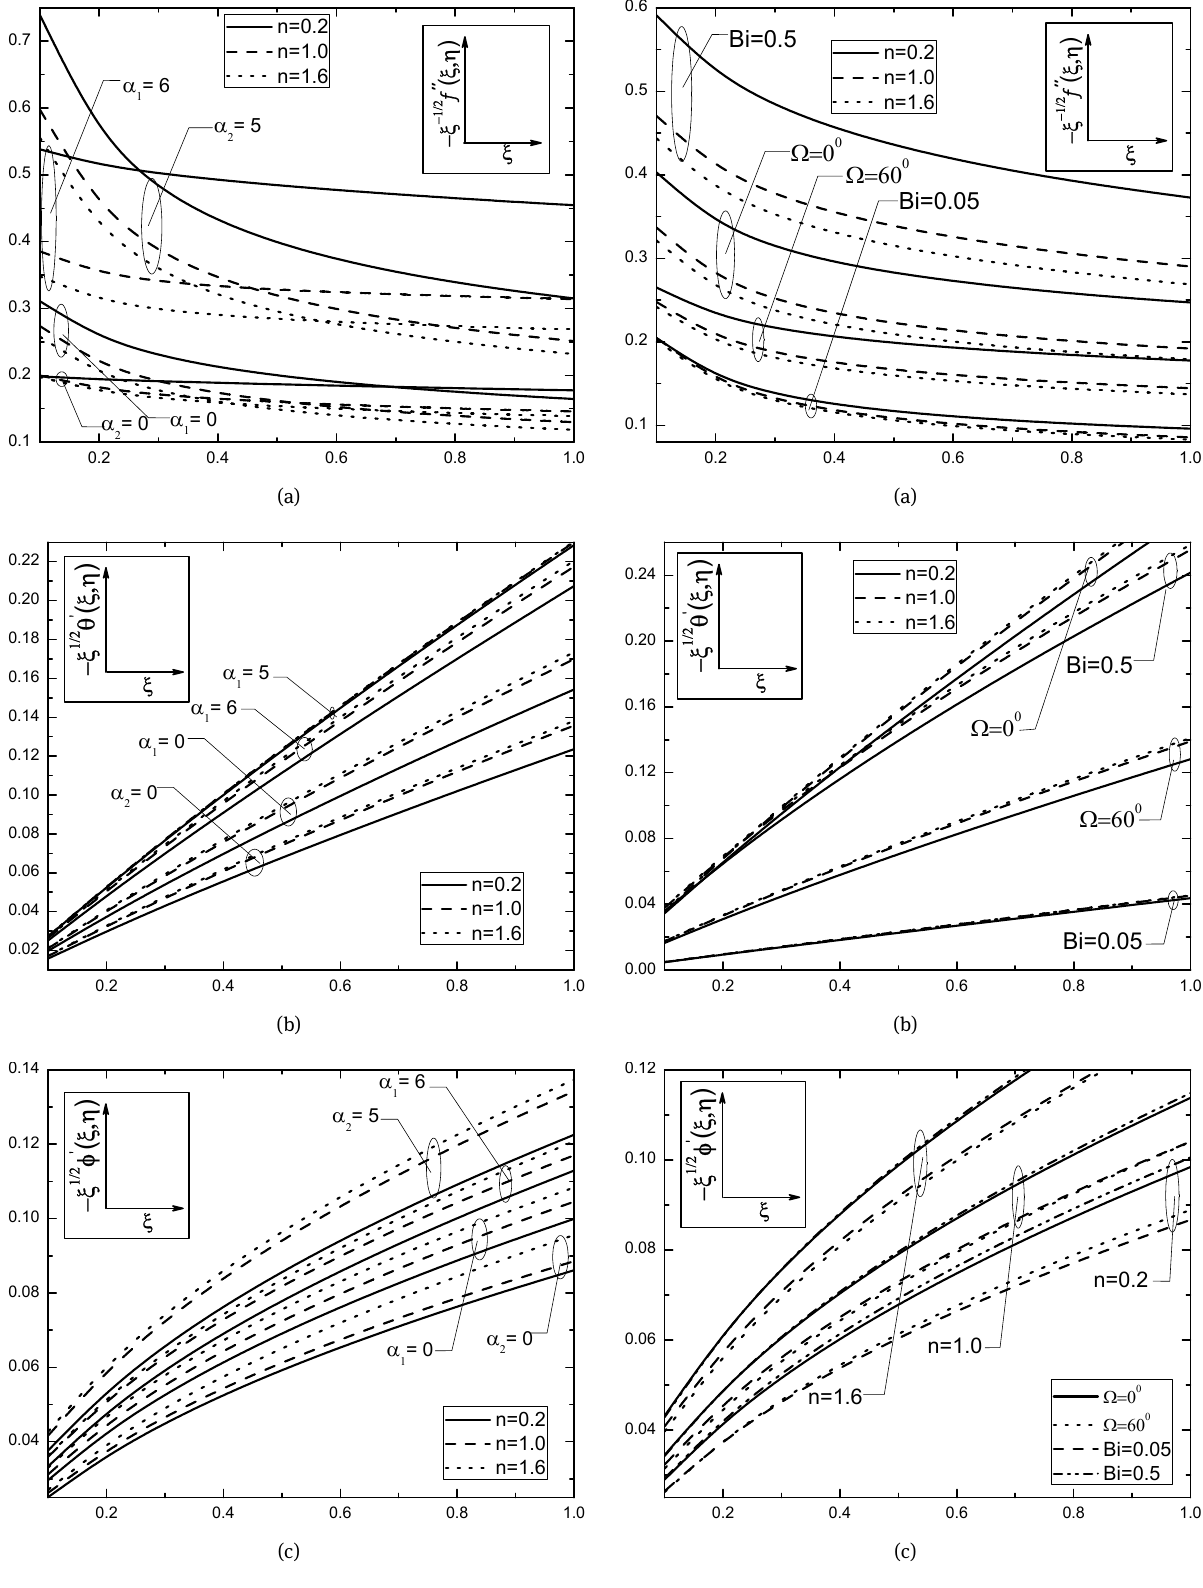
Fig. 7: Effect of α 1 and α 2 for different values of n on the (a) skinfric- tion, (b) Nusselt number, and (c) Sherwood number, against ξ with the fixed values of Bi = 0.5 and Ω = 30 0 .